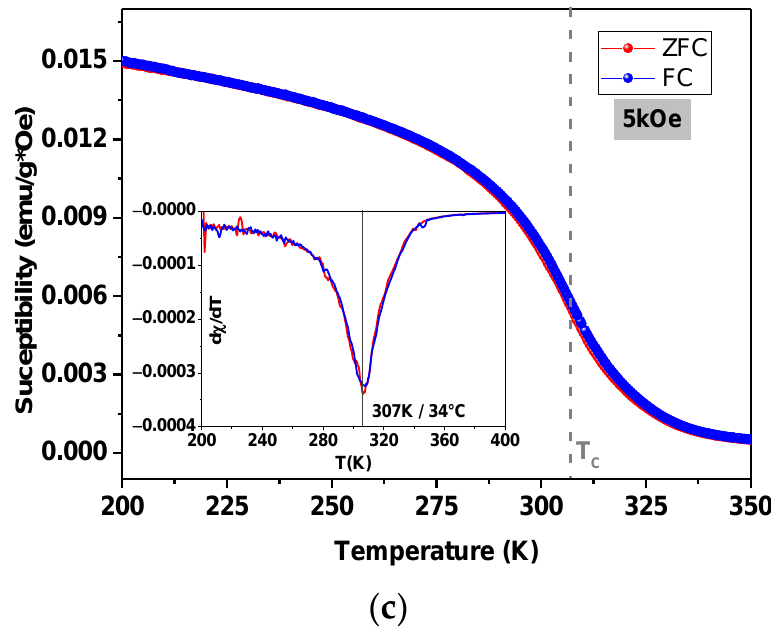
Figure 9. Temperature dependence of the magnetization (ZFC-FC) of the LSM sample for different magnetic fields accuracy 10 − 8 emu, and temperature uncertainty ± 0.5 K ( a ) 100 Oe; ( b ) 1 kOe; ( c ) 5 kOe.